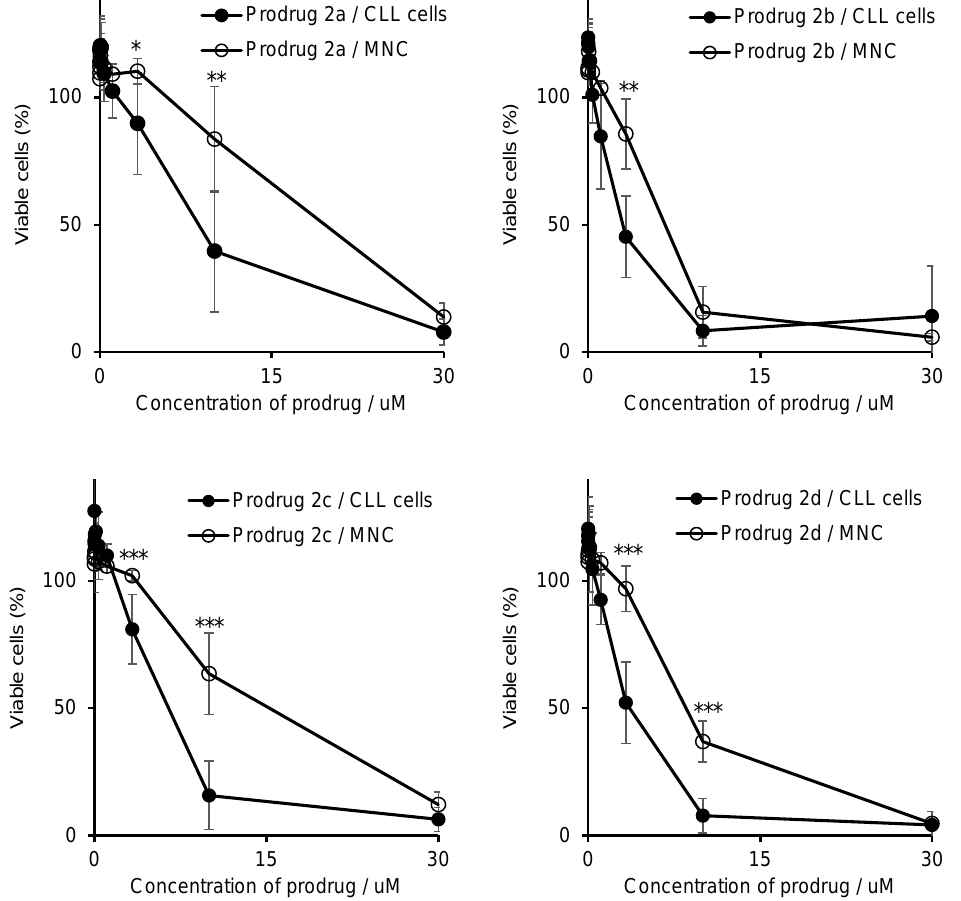
Figure 7. Effect of prodrugs 2a - 2d on the viability of primary CLL cells and primary MNC’s. *: p < 0.05; **: p < 0.01; ***: p < 0.001 (Student’s t -test).